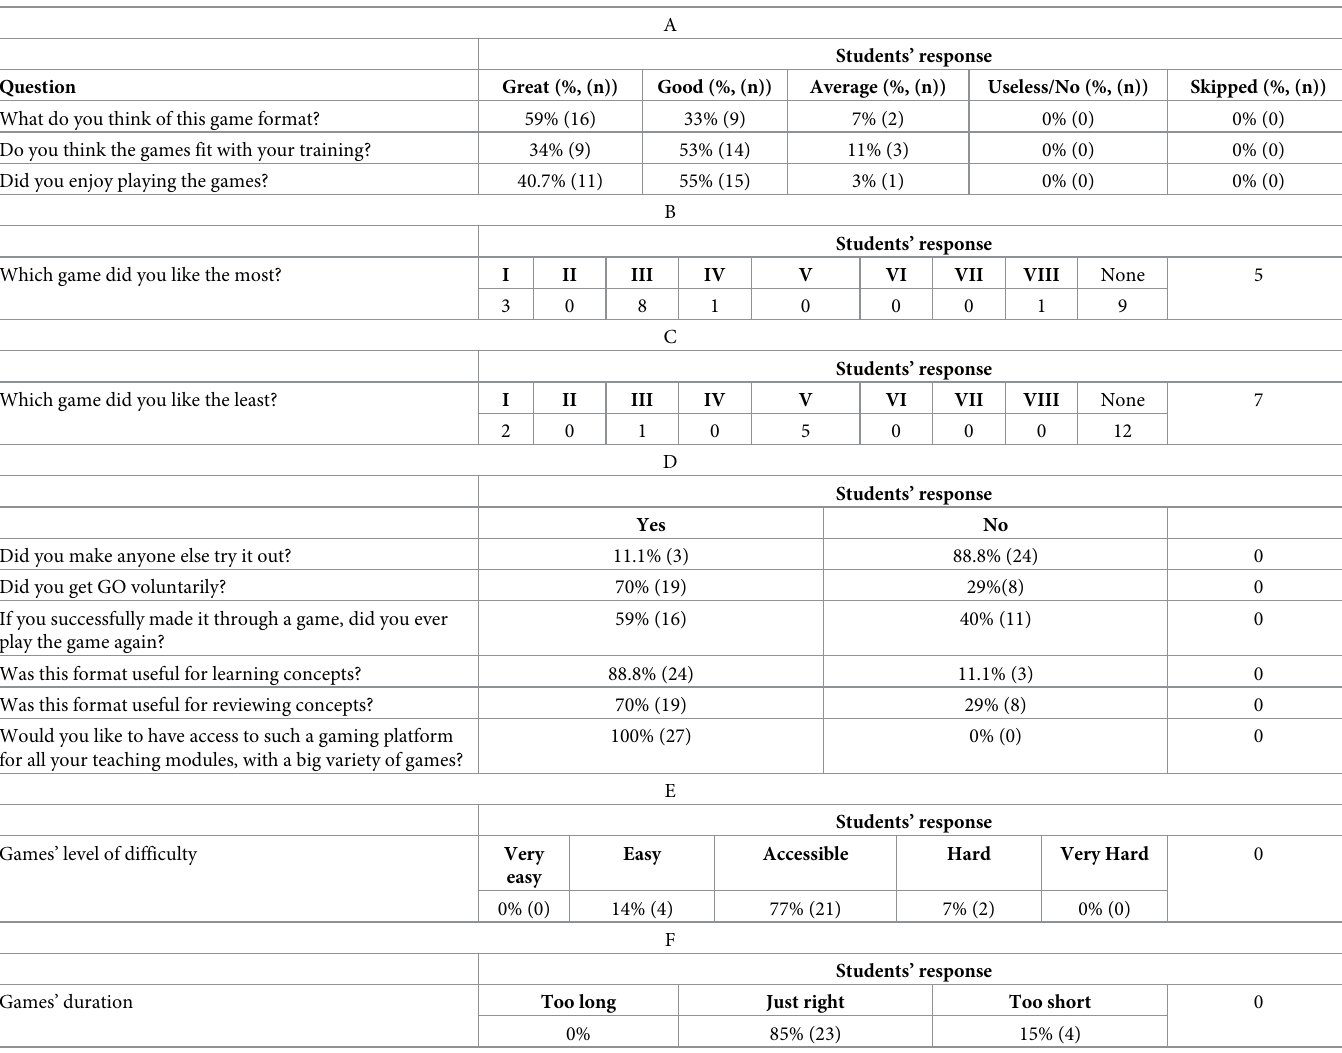
Table 2. Results μ of the students’ satisfaction